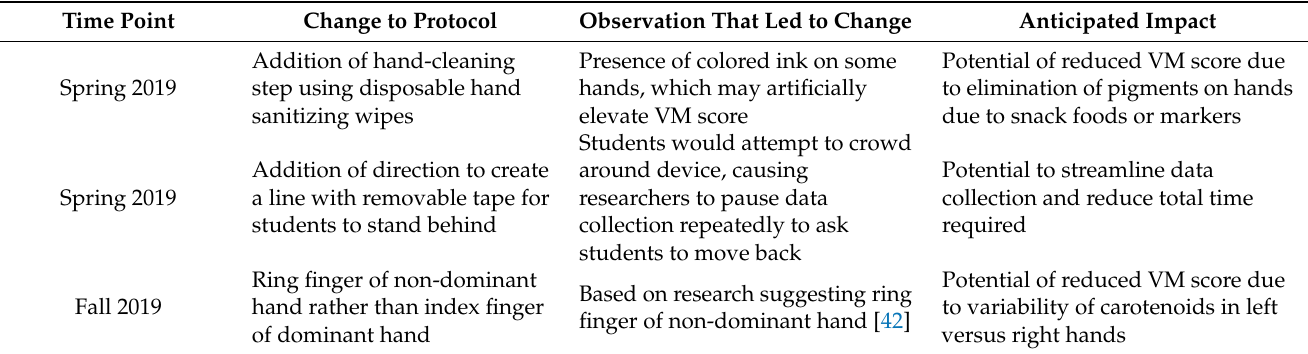
Table 4. Updates to protocol over course of